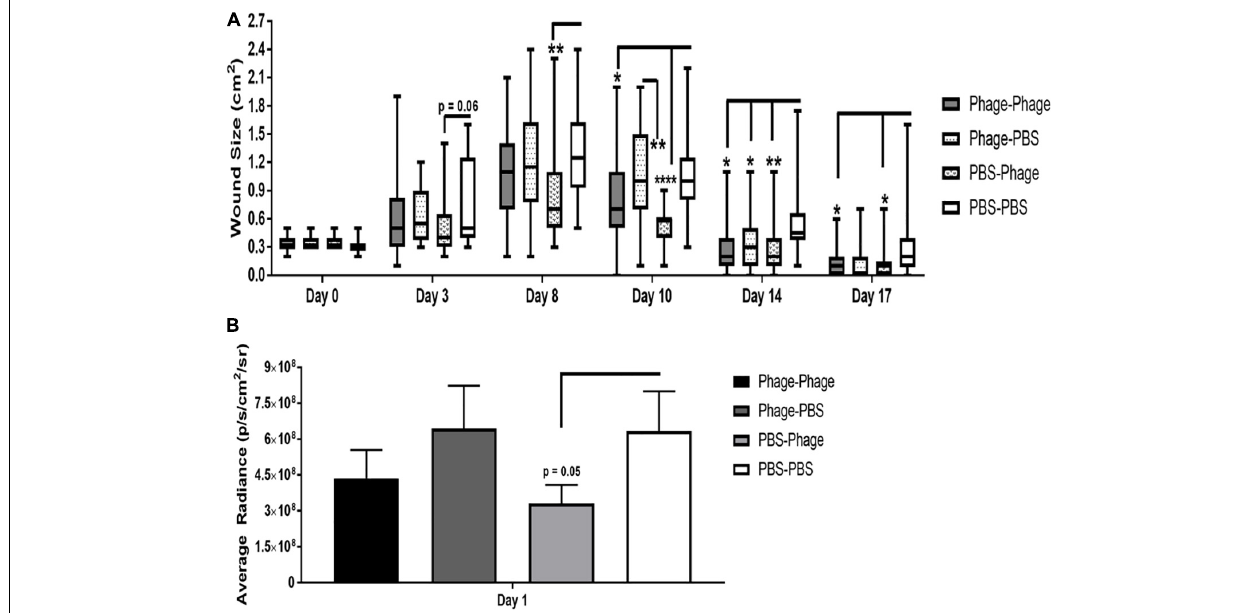
FIGURE 8 | Effects of phage mixture on wound closure and bacterial burden following A. baumannii infection. Balb/c mice pre-immunized with PBS or phage mixture were immunosuppressed with cyclophosphamide before wounding (dorsal full thickness injury) and challenged topically with AB5075-lux. (A) Wound size measure by Aranz system. (B) Bacterial burden measured by IVIS. N = 27 per group per time point; * p < 0.05, ** p < 0.01, **** p <